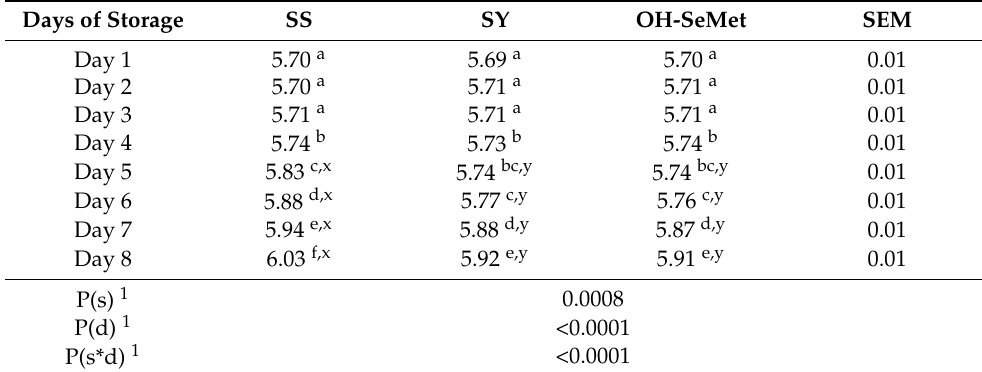
Table 4. Least square means pertaining to the effect of the selenium source during the finishing phase on the pH of the meat during 8 days of storage.